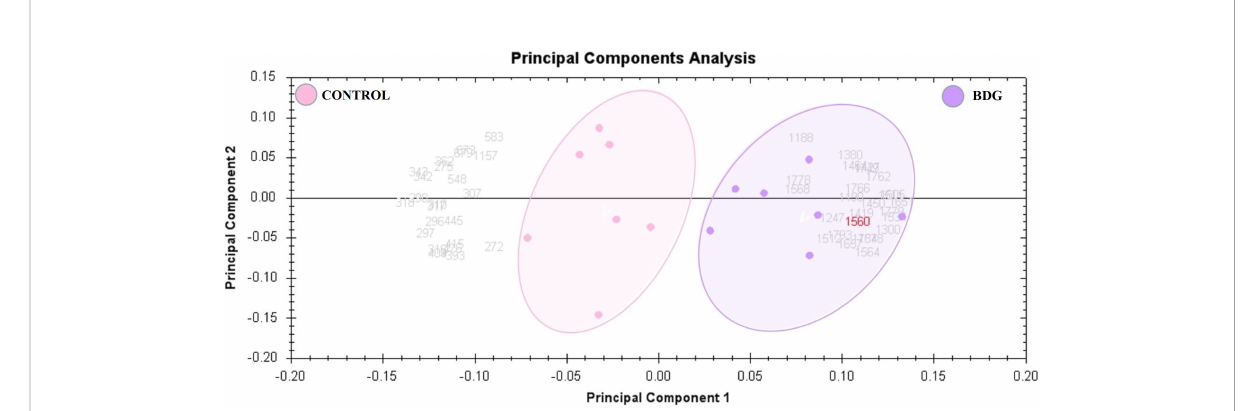
FIGURE 2 The two fi rst principle components are plotted on a PCA. Together, they explained 82 percent of the variability in the chosen spot. Gels and spots are represented as colored dots and numerals,